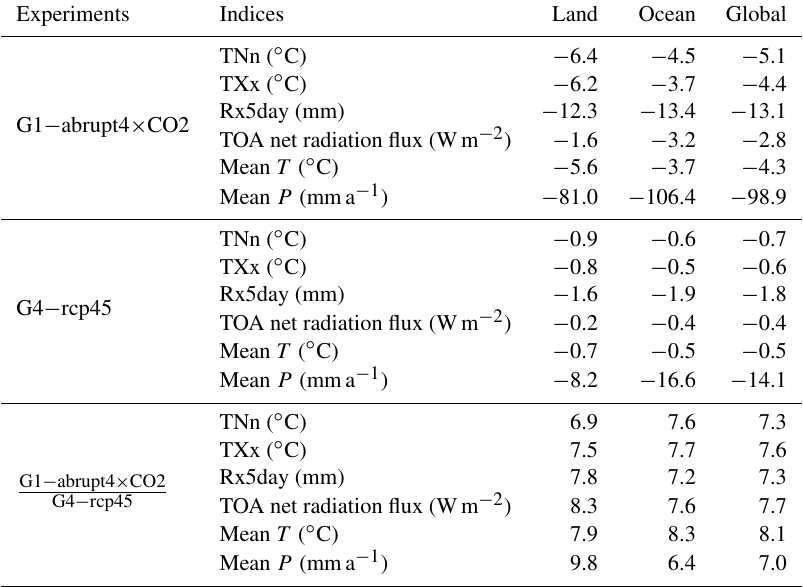
Table 3. Differences and ratios in means and climate extreme indices over the 40-year analysis period. Experiments Indices Land